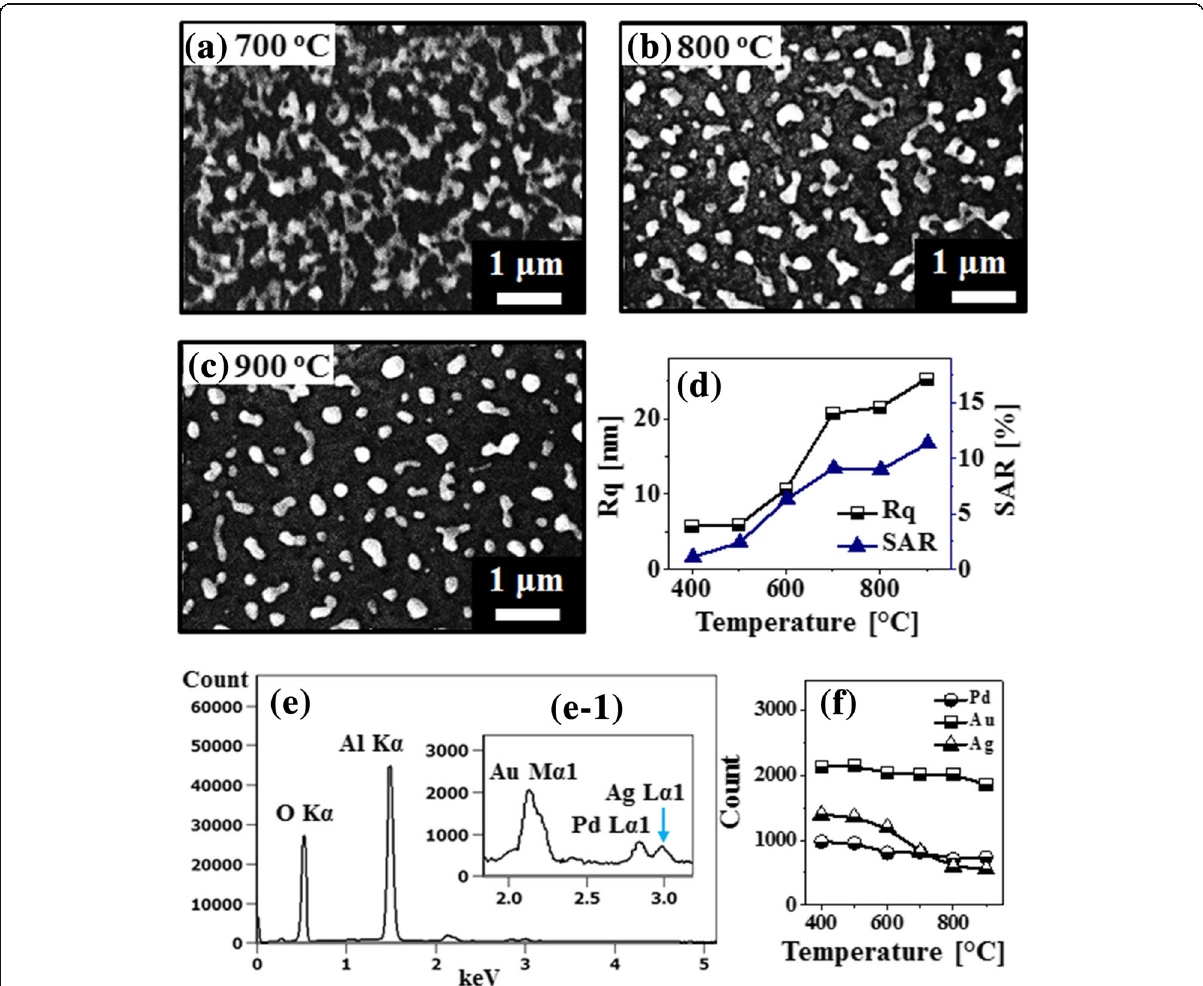
Fig. 2 a – c SEM images of tri-metallic PdAuAg NPs annealed between 700 and 900 °C (tri-layers). d Plots of RMS surface roughness (Rq) and surface area ratio (SAR) of corresponding samples as a function of annealing temperature. e Energy dispersive X-ray spectroscopy (EDS) full spectrum of sample annealed at 400 °C. f Plots of Pd, Au, and Ag EDS